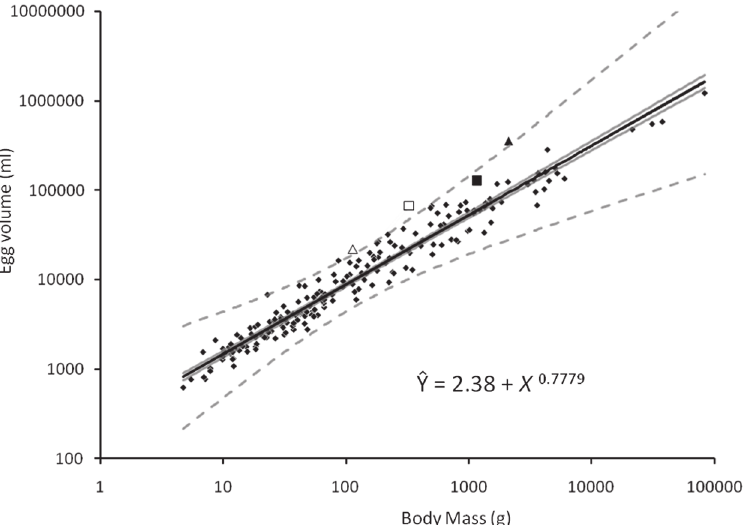
Fig 1. Family means of egg volume expressed as a function of mean body mass (families follow Dickinson 2003), grey lines denoting confidence intervals (standard error) and dotted lines defining 95% confidence intervals. Three families produce an egg more than two standard deviations greater than the volume predicted by body size: Pelecanoidiidae (Diving Petrels; denoted as an open triangle), Dromadidae (Crab Plover, denoted as an open square) and Apterygidae (Kiwis; denoted as a closed triangle); Megapodiidae (Megapodes; denoted as a closed square) not departing from the overall relationship.